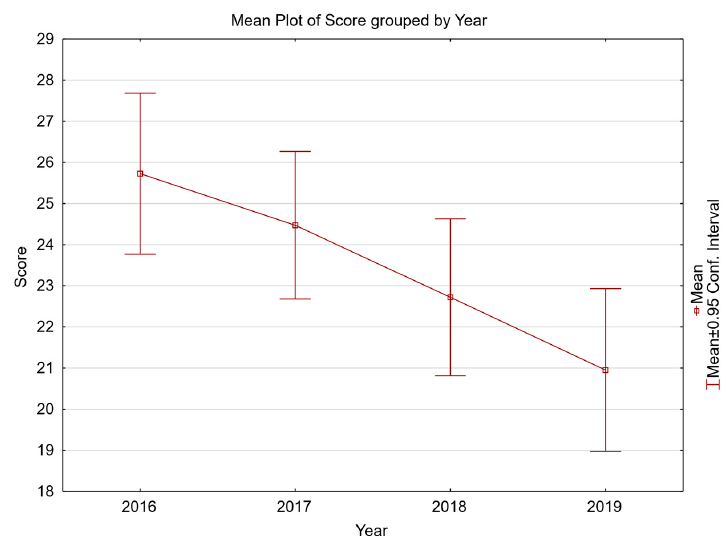
Figure 6. Graphical visualisation of statistical characteristics of groups (points awarded in the admission procedure).